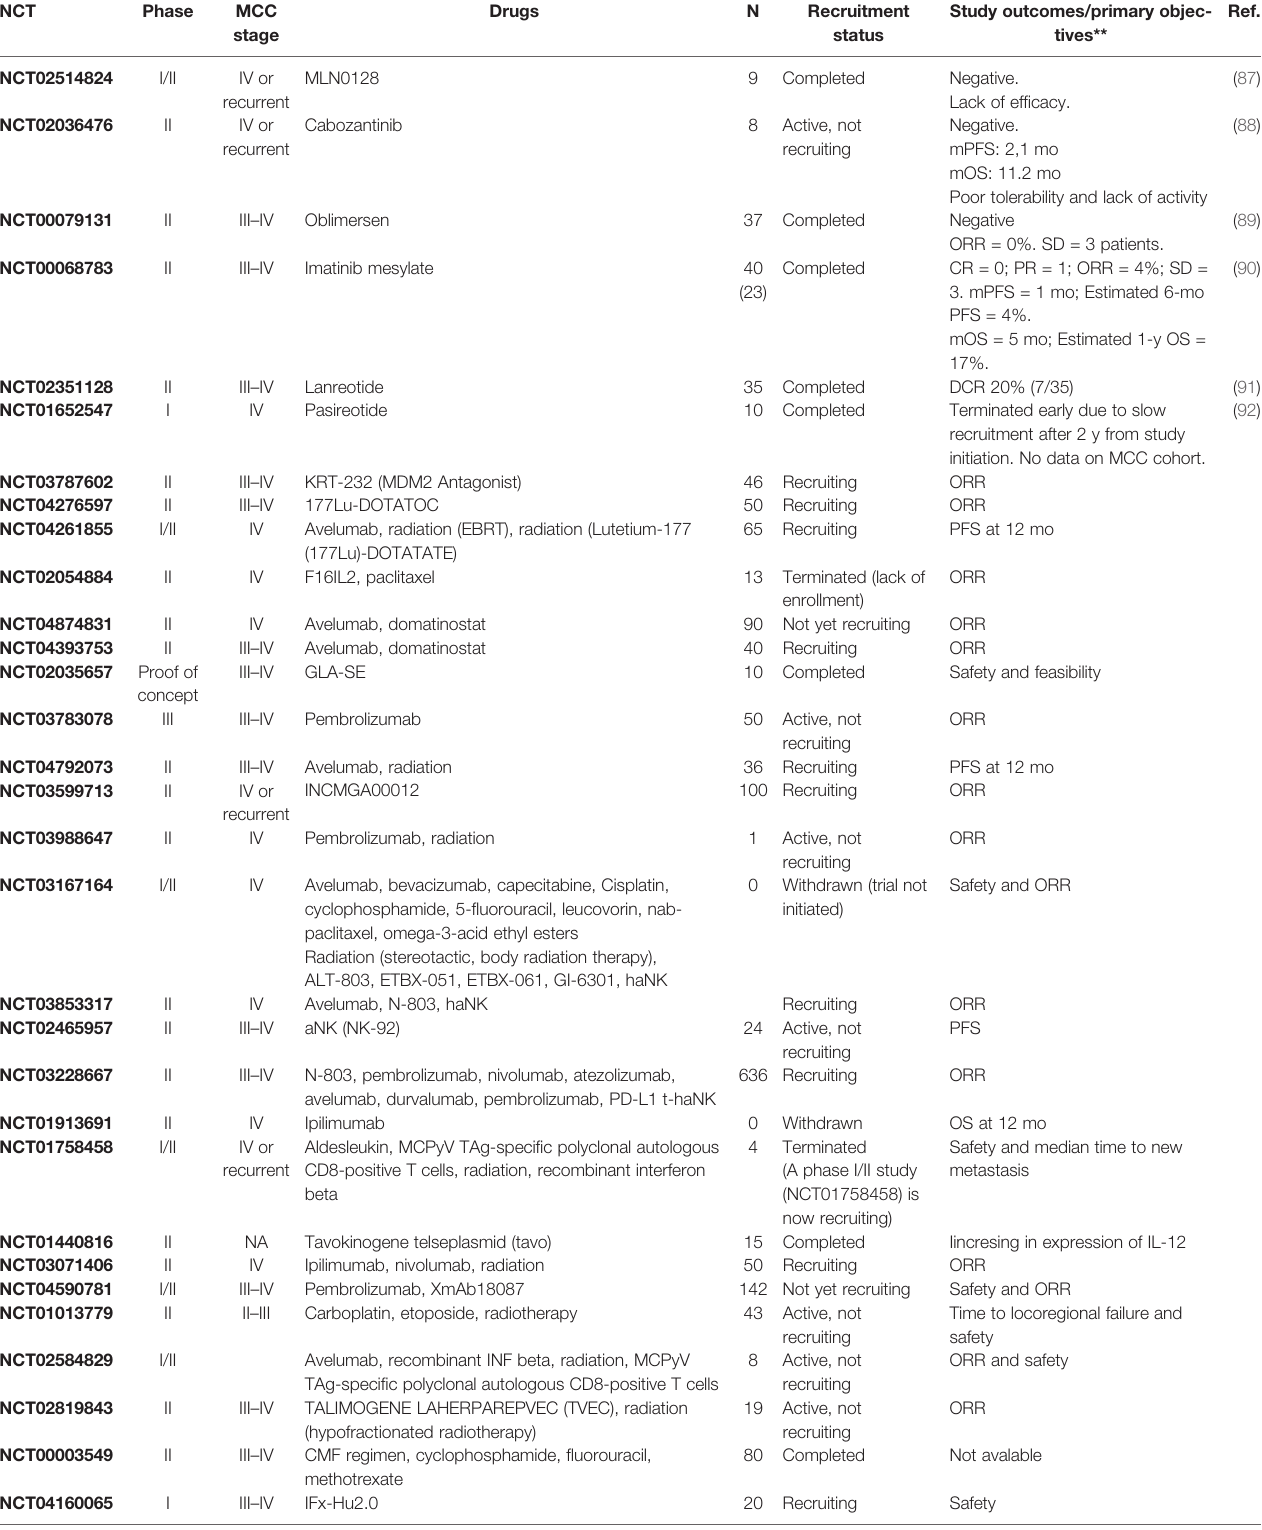
TABLE 3 | Summary of all available trials for the treatment of locally advanced or metastatic